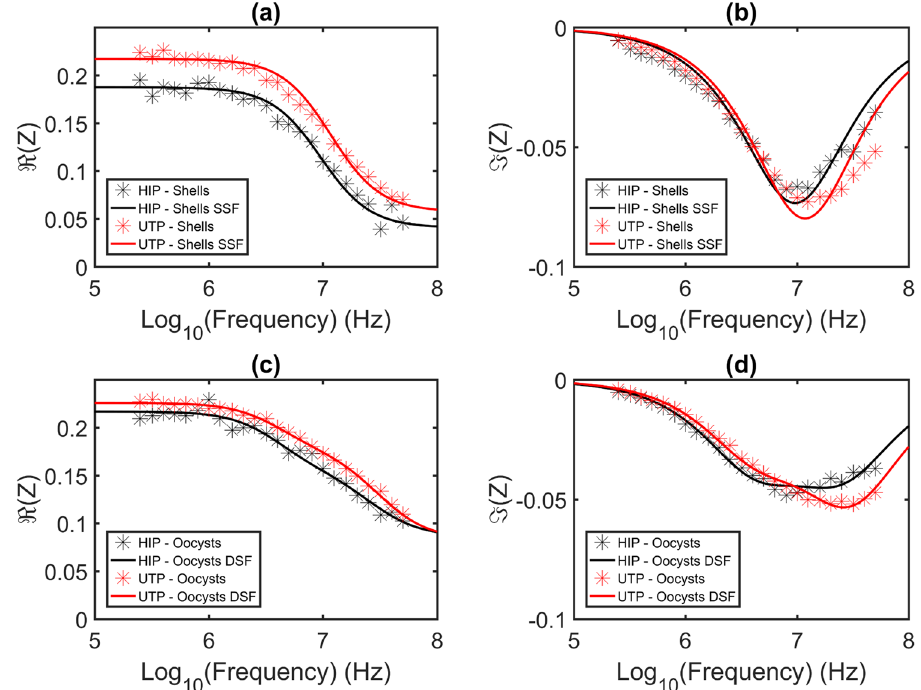
Figure 5. Impedance spectrum for untreated (UTP) and heat-inactivated C. parvum (HIP) in the frequency range 250 kHz to 50 MHz, for a buffer conductivity of σ m = 0.76 S m − 1 . The mean value of the real ( R (Z)) and imaginary ( I (Z)) parts of impedance for shells (( a ) and ( b )) and oocysts (( c ) and ( d )), respectively, is plotted (stars). The two sets of data were then modelled using a single shell fit (SSF) for shells (( a ) and ( b )) and a double shell fit (DSF) for oocysts ( (c) and (d) ), and plotted over the data (solid